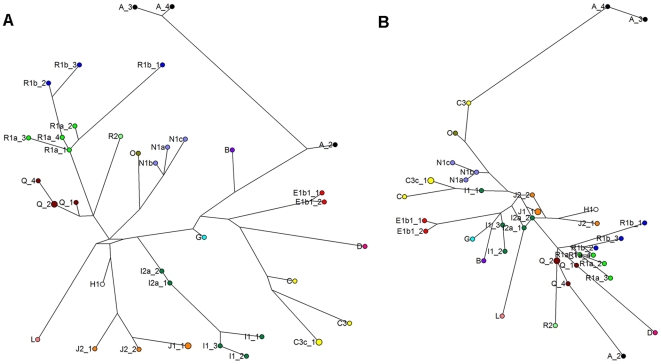
Networks of STR haplotypes based on penta- and hexanucleotide STRs, with and without SNPs.Median joining networks of Y chromosome STR haplotypes with balanced sample sizes from each haplogroup. A network based on 9 penta- and hexanucleotide STR markers and SNPs; B network based solely on the data of the 9 penta- and hexanucleotide STR markers used in this study. Nodes are named according to the haplogroups of the samples. STR markers employed in network construction: DYS448, DYS596, Y PENTA 1, Y PENTA 2, DYS438, DYS594, DYS643, DYS645, DYF411S1.